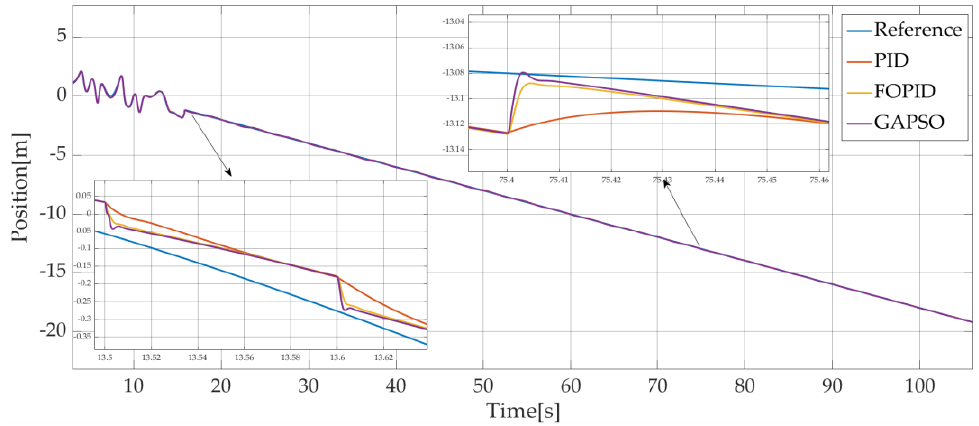
Figure 20. L = 27 m, V = − 0.2 m/s, Position of the load without compensation.